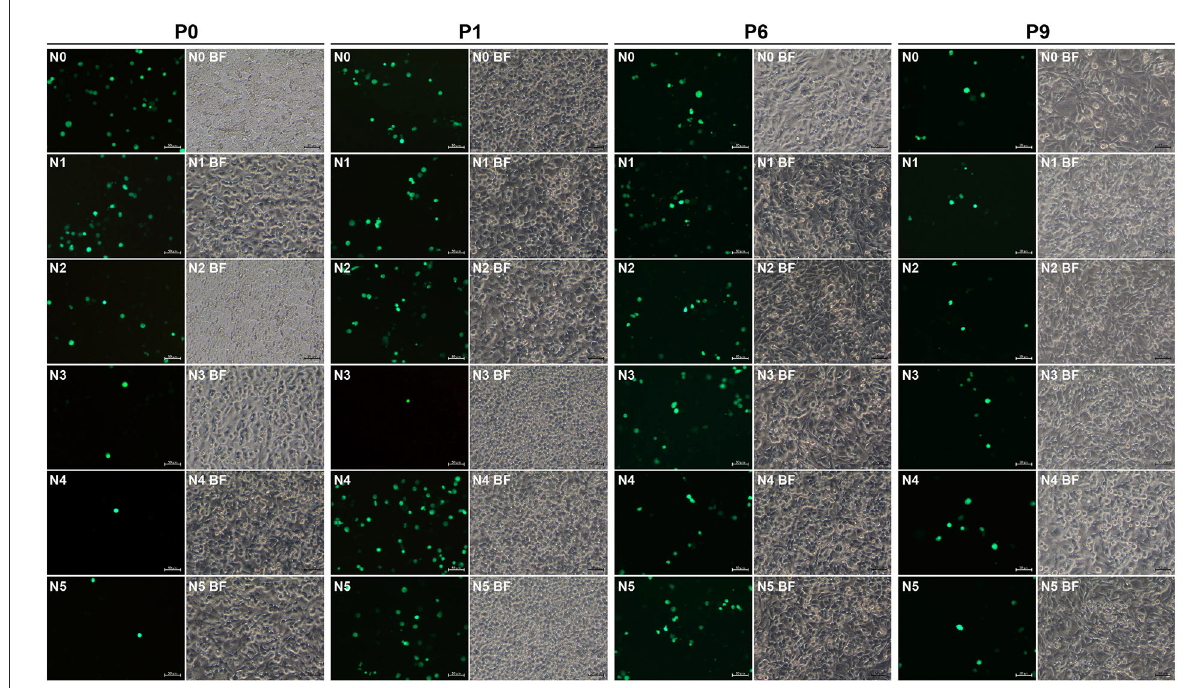
FIGURE3 Rescue and passaging of rSVA-N0 to -N5. Green fluorescence is visible on cell monolayers during serial blind passaging. BF, bright field. P0: passage-0 at 72 hpt. P1, P6 and P9: passage-1, − 6, and − 9 at 48 hpi. Bar = 50 µ m.